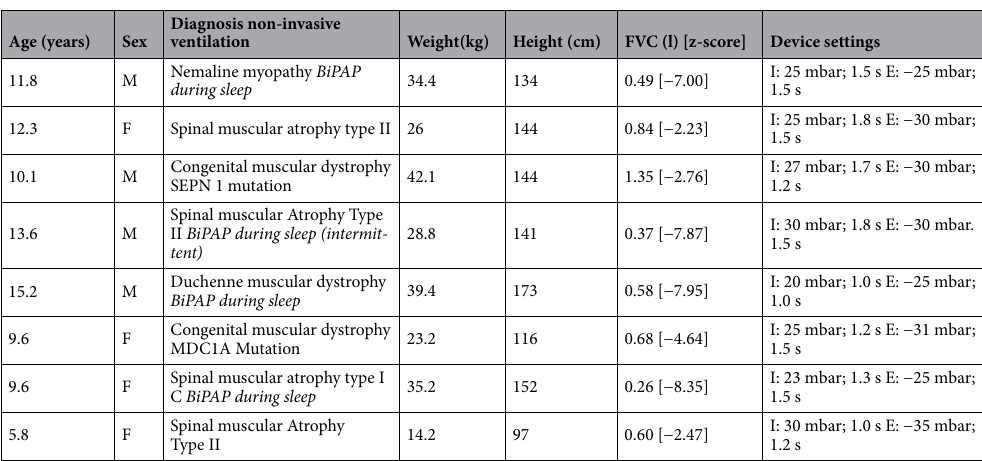
Table 1. Demographic data including diagnosis, baseline vital capacity and device settings. F: female; M: male; FVC: forced vital capacity; I: insufflation; E: